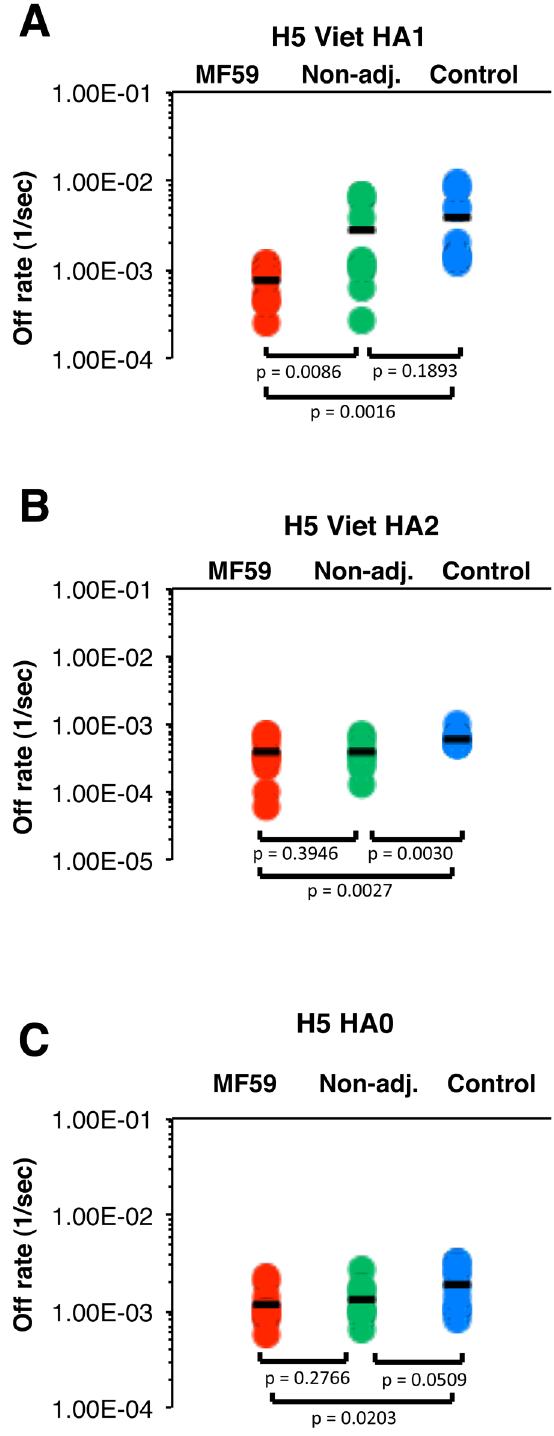
Figure 3. MF59-H5N3 priming enhances antibody affinity (slower off-rates) to H5N1-HA1 (but not HA2) following a single heterologous H5N1 booster vaccination. (A–C) SPR analysis of post-H5N1 vaccinated human sera from all the H5N1-A/ Vietnam/1203/2004 responders (MN $ 1:40) in three vaccine groups was performed with properly folded HA1 (A), HA2 (B) domains or HA0 (C) from H5N1 A/Vietnam/1203/2004 strain. Off rates of polyclonal antibodies on day 21 following a single H5N1 booster vaccination from the MF59- adjuvanted H5N3 primed (red symbols) or unadju- vanted H5N3 primed (green symbols) individuals, or after